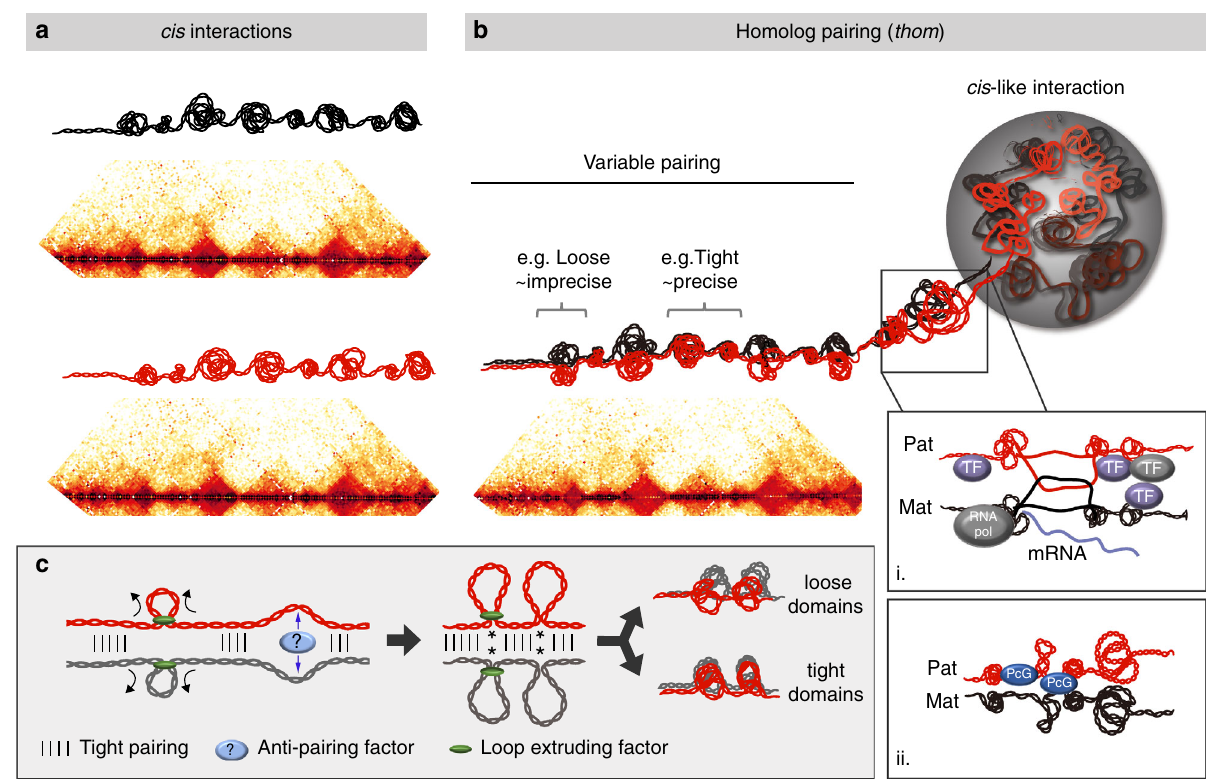
Fig. 4 Haplotype-resolved Hi-C in PnM cells distinguished different forms of thom from cis interactions. a Cis contact maps for two homologs and schematics depicting possible cis interactions. b Thom contact map demonstrating a variable structure of pairing, including tight, precise pairing interspersed with looser, less precise pairing. Thom interactions encompass organizational structures that are concordant with cis behavior and could facilitate a variety of transcriptional states, including i. active or ii. repressive environments. c Left: Homologous loops between tightly paired regions may form by extrusion (black arrows), anti-pairing (blue arrows), or a combination of both. Right: Here, loops could result in thom domains that are either loosely paired (top), or railroad-track paired throughout if they fold back on each other, (bottom), with cis -maternal and cis -paternal domain boundaries concordant in both scenarios. Note, loop extrusion in mammalian systems is proposed to involve a cohesin ring 79,80 (green oval) through which a single chromosome passes, suggesting that extrusion in the context of pairing may involve the passage of each homolog separately (shown) or two homologs simultaneously (not shown), the outcome of which could be either loosely or tightly paired domains. In a nonexclusive alternative, loops are formed by anti- pairing 29 , where pairing might be counterbalanced with unpairing via anti-pairing factors such as Cap-H2. Interestingly, extrusion and/or anti-pairing could bring enhancers and promoters together at the base of the loops (indicated by *), activating transcription, such as might happen in tightly paired regions. In the context of anti-pairing, this could explain the curious co-localization of Cap-H2 with regions of tight pairing (Supplementary Table 3; also ref. 27